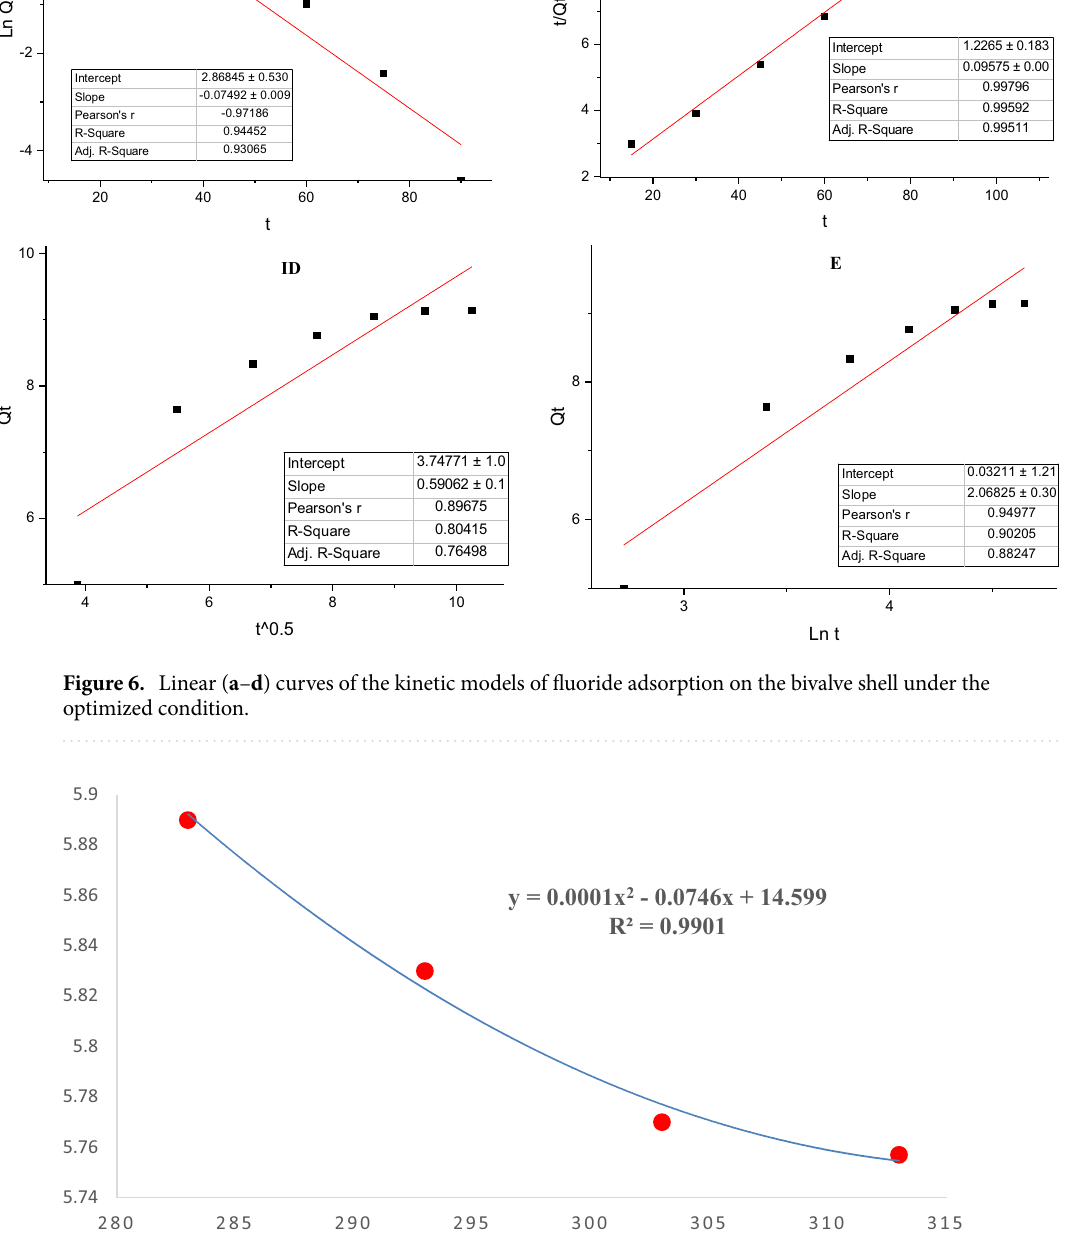
Figure 7. Effect of temperature on adsorption capacity of Bivalve Shell in Fluoride